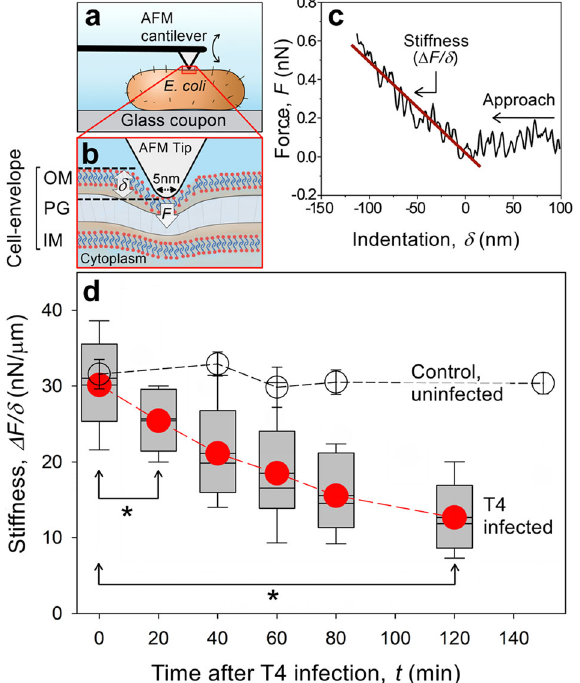
Fig. 4 Stiffness measurements of the E. coli cell envelope during T4 infection. a , b Schematic illustration of AFM stiffness measure- ment using a pyramid AFM tip (not to scale). The force of the nanometer end-tip ( F ) that was applied caused an indentation ( δ ) of the cell envelope, including the outer/inner membrane (OM/IM) and the peptidoglycan layer (PG). c A representative AFM force vs. indentation that demonstrates how the stiffness was calculated. Approach velocity was 190 ± 20 µm/s. d Stiffness (rigidity) changes with time for different bacteria with (box plot with red circles indicating the average) and without (empty circles) the addition of T4 phages. Average stiffness and the corresponding standard deviation (s.d.) were based on 45,000 force measurements taken from 4 to 5 areas on the surface of each bacterium. Asterisks indicate a statistically signi fi cant difference between two time points ( p < 0.01, n = 12 at 3 – 5 independent experiments).